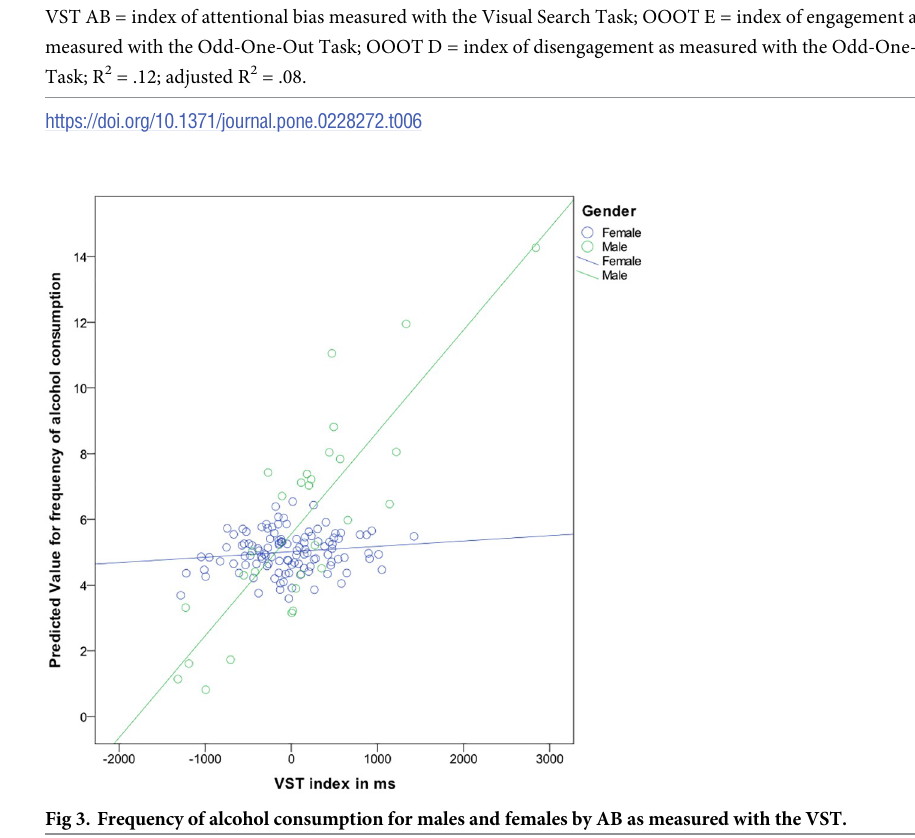
VST AB = index of attentional bias measured with the Visual Search Task; OOOT E = index of engagement as measured with the Odd-One-Out Task; OOOT D = index of disengagement as measured with the Odd-One-Out Task; R 2 = .12; adjusted R 2 = .08.